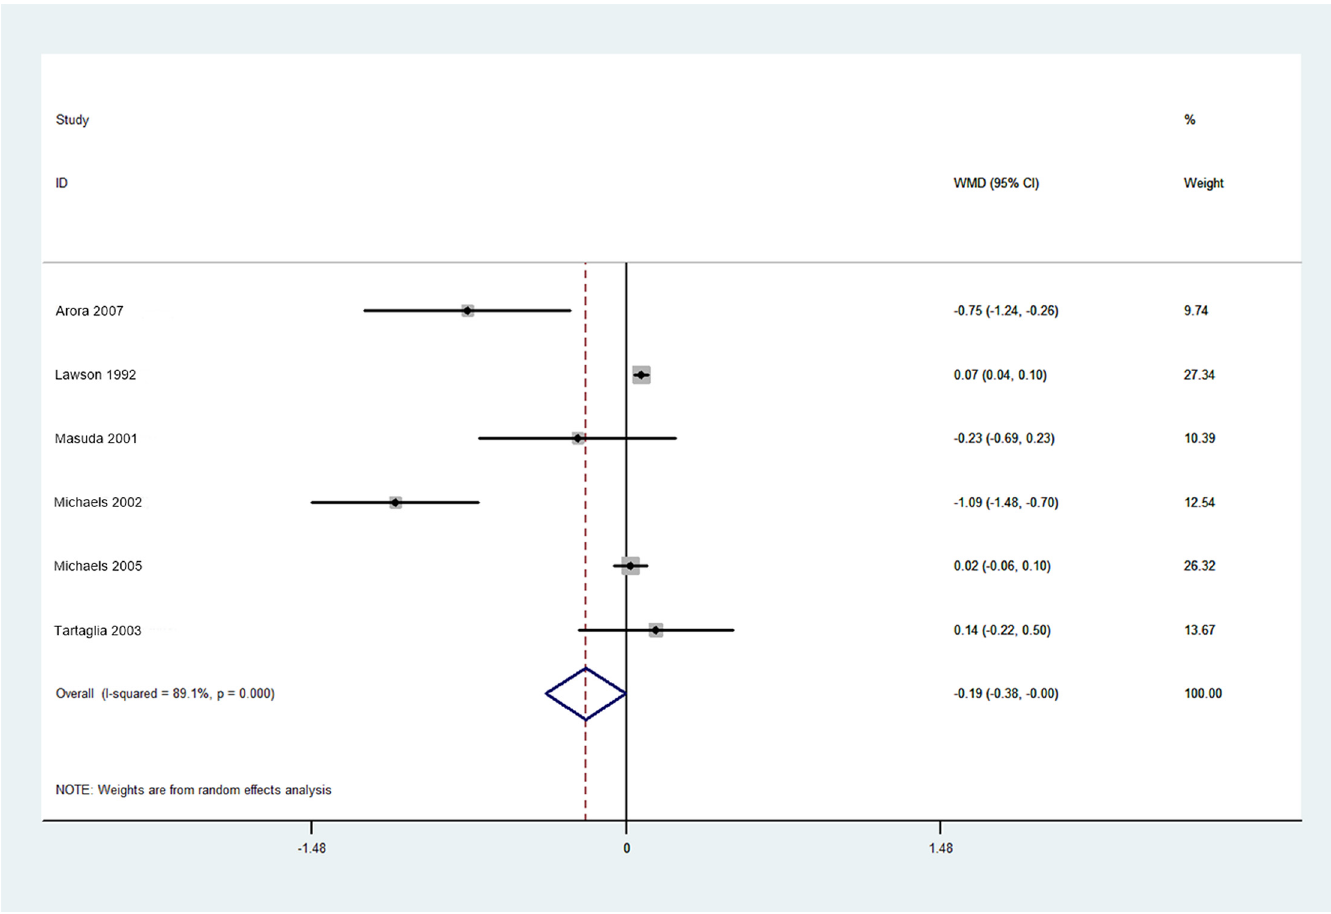
Fig 2. Forest Plot of Weighted Mean Differences in Myocardial Perfusion Pre- and Post-EECP.